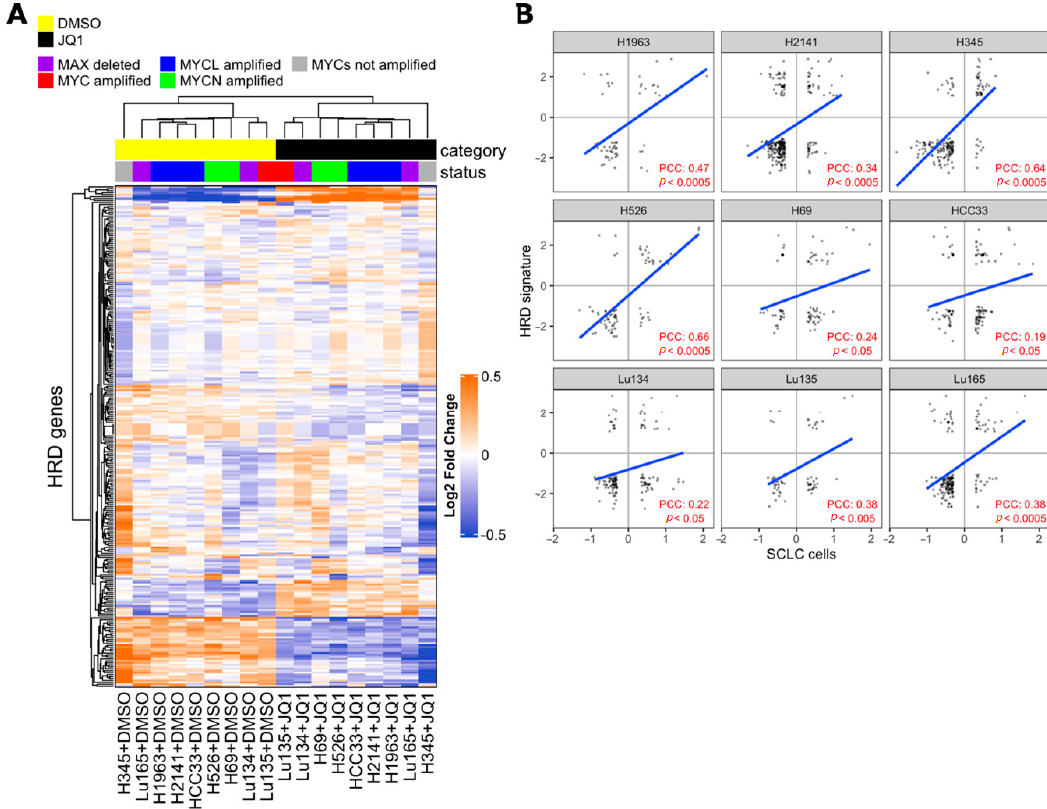
Figure 4. Effect of Bromodomain and Extra-Terminal domain (BET) inhibition on SCLC cells correlates with homologous recombination defect (HRD) signature. ( A ) Heatmap from unsupervised clustering of HRD gene signatures (PMID 24553445) using the gene expression data of SCLC cell lines with or without 1 µM BET inhibitor JQ1 treatment for 24 h of culture (PMID 27764802). JQ1-treated cells formed a cluster with the HRD gene signature. ( B ) Pearson correlation coefficient (PCC) between fold change of HRD genes in SCLC cells (JQ1 vs DMSO) and median fold change of HRD genes in MCF10A BRCA1kd , MCFA10 RAD51kd , and MCF10A BRIT1kd cells vs control cells (HRD signature). Values are expressed in log2 scale. PCC and p -values were calculated with R software, cor.test, and lm functions.